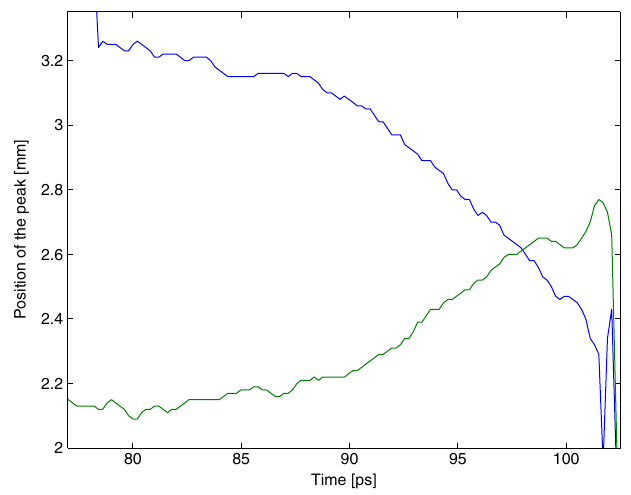
FIG. 4. (Color) Position of the horizontal (blue) and vertical (green) center of the coherently excited signal along the length of the electron bunch. The positions are measured from the top- left corner of the small images in Fig.